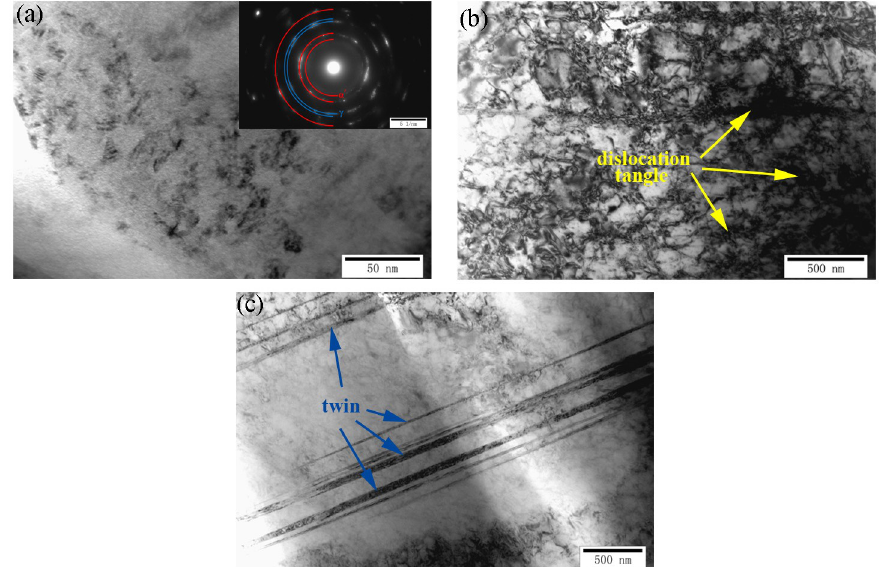
Figure 4. Bright field TEM image of the USR sample ( a ) in the top-surface layer, ( b , c ) in the deformation zone. The insert in ( a ) shows the corresponding SAED patterns.